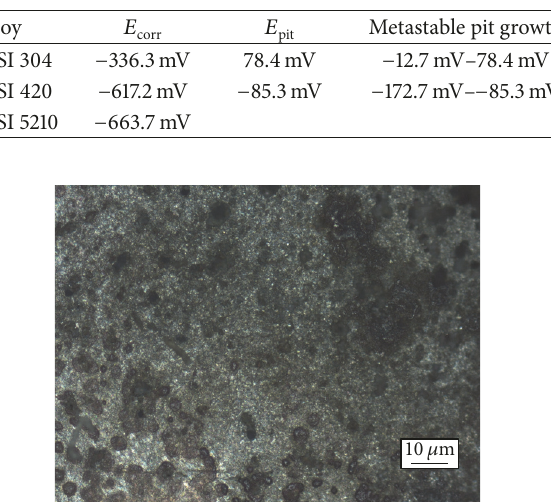
Table 3: Characteristic values for potentiodynamic polarization scans in phosphate buffer with 3.5 wt.% NaCl.